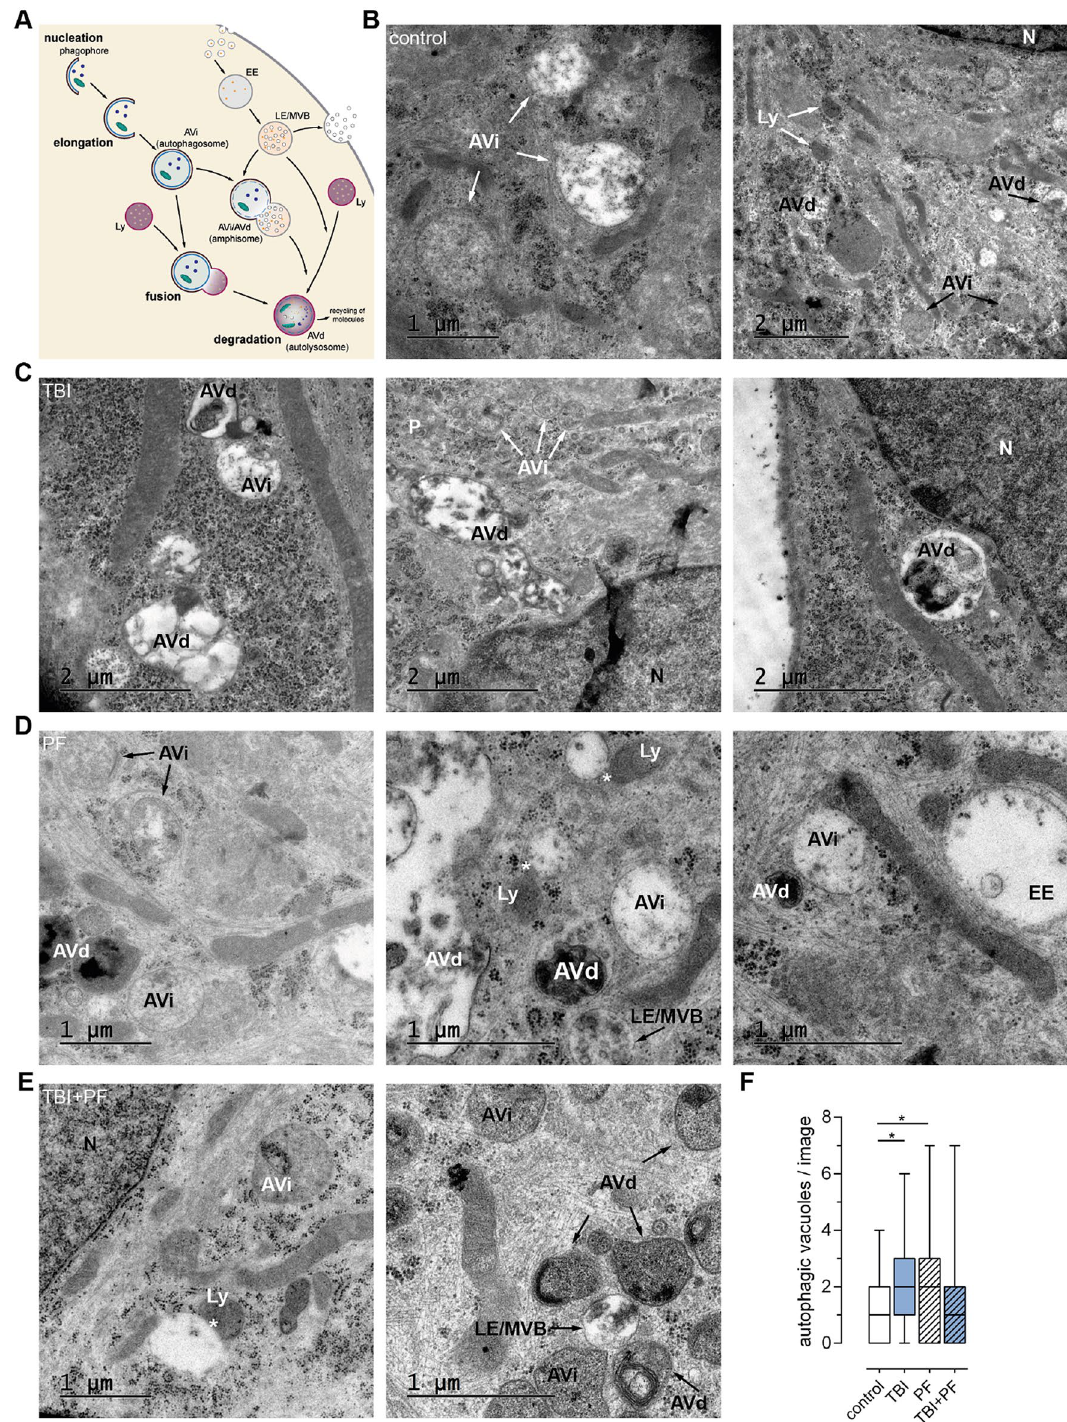
Figure 8. Autophagic and endocytic compartments depicted by transmission electron microscopy. ( A ) Schematic depiction of the autophagic and endocytic pathways used by the cells for the degradation and recycling of material. ( B – E ) TEM images of control ( B ), TBI ( C ), PF ( D ) and TBI + PF ( E ) cells. Autophagic and endocytic vacuoles at various stages of maturation are denoted. ( F ) The number of autophagic vacuoles (AVi and AVd) per TEM image was quantified; analyzing a total of 55–68 TEM images of five cells per experimental group. Statistical analysis was conducted using the Kruskal–Wallis test followed by Dunn’s multiple comparisons test, *p ≤ 0.05 **p ≤ 0.01 ***p ≤ 0.001. Potential fusion events are marked by stars (*). Abbreviations used: AVd degradative autophagic vacuole/autophagic compartment, AVi immature autophagic